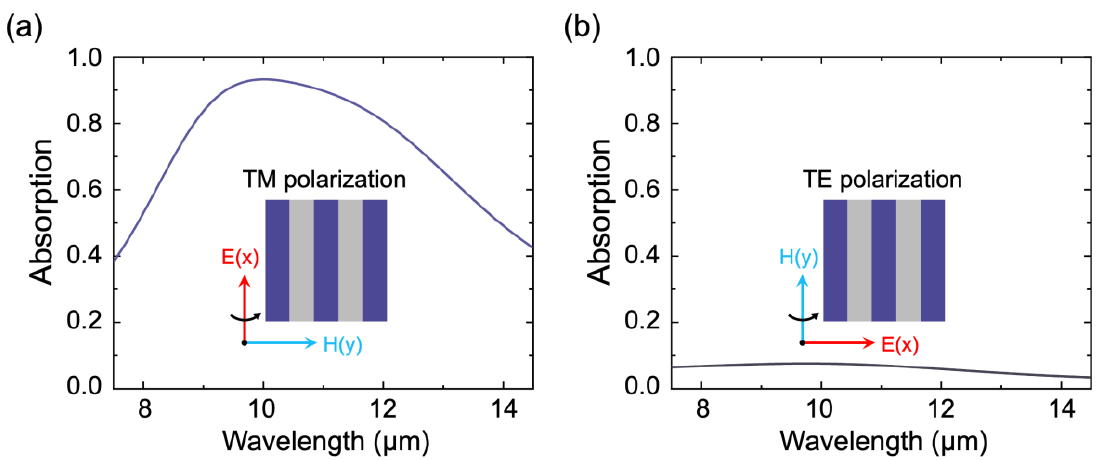
Figure 2. Simulated absorption spectrum of designed MIM absorber under ( a ) TM- and ( b ) TE- polarized light.